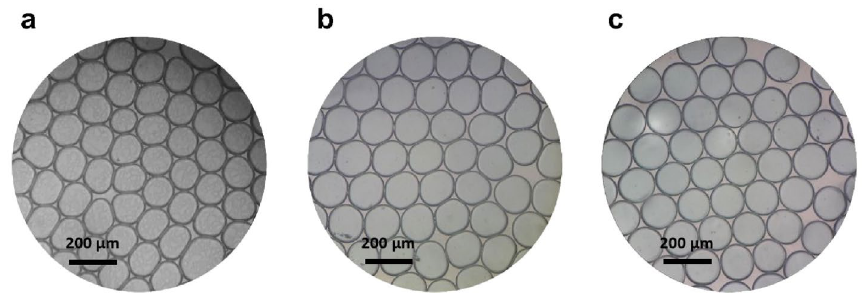
Figure 3. Comparison of droplets behavior in oil-blended PDMS chip with ( a ) 0, ( b ) 3, and ( c ) 7% mineral oil after amplification (bright-field microscopy